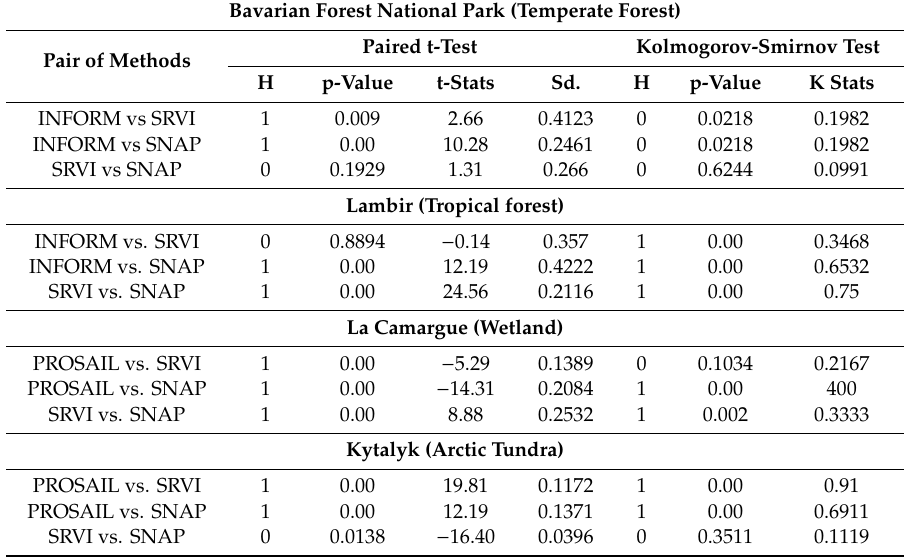
Figure 8. Seasonal variability of CCC between June 2017 and September 2018 in the Bavarian Forest National Park. The broken lines show the seasonal variation in broadleaf stands, and the solid lines in a conifer stand for randomly selected two pixels.